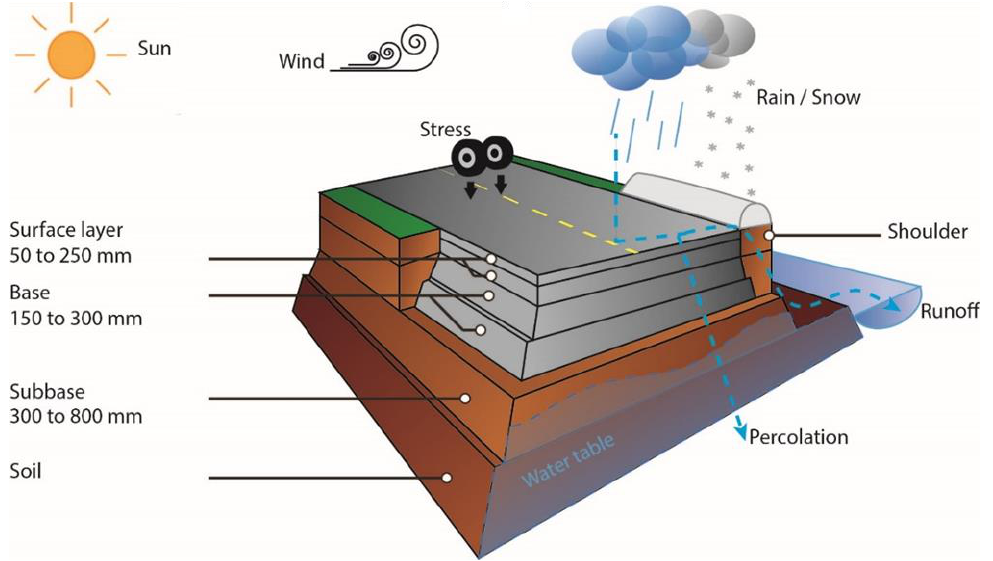
Figure 2. Schematic road structure adapted from Segui [17].